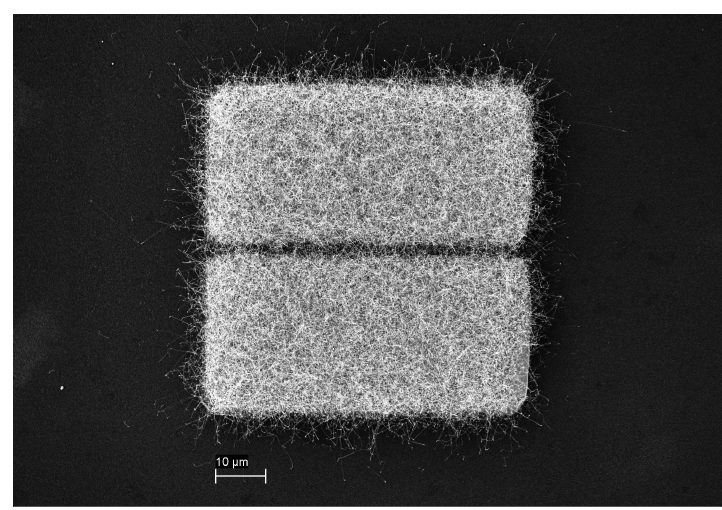
Figure 11. SEM picture of patterned growth of SnO 2